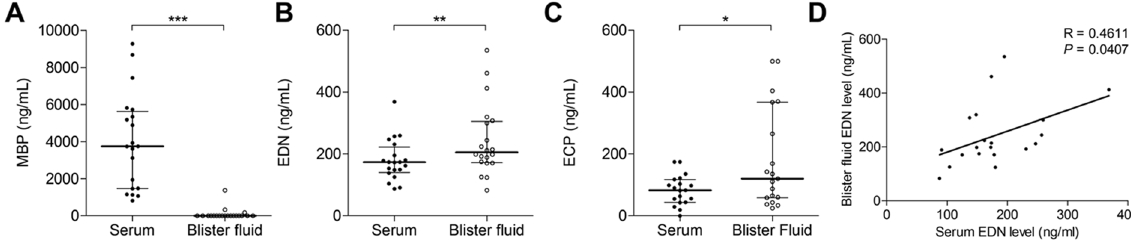
Figure 4. Comparison of serum and blister fluid concentrations for MBP, ECP and EDN in 20 patients with active bullous pemphigoid. The serum blister fluids concentrations of MPB ( A ), EDN ( B ) and ECP ( C ) were measured by means of specific ELISAs. Variations between serum and blister fluids were analyzed by means of Wilcoxon test for MBP and EDN and paired t test for ECP. Correlation between EDN concentrations in the serum and in the blister fluids was performed by means of Spearman’s correlation coefficient analysis. Statistical significance was as follow: ( * P < 0.05, ** P < 0.01; *** P < 0.001 ). Lines define median and interquartile